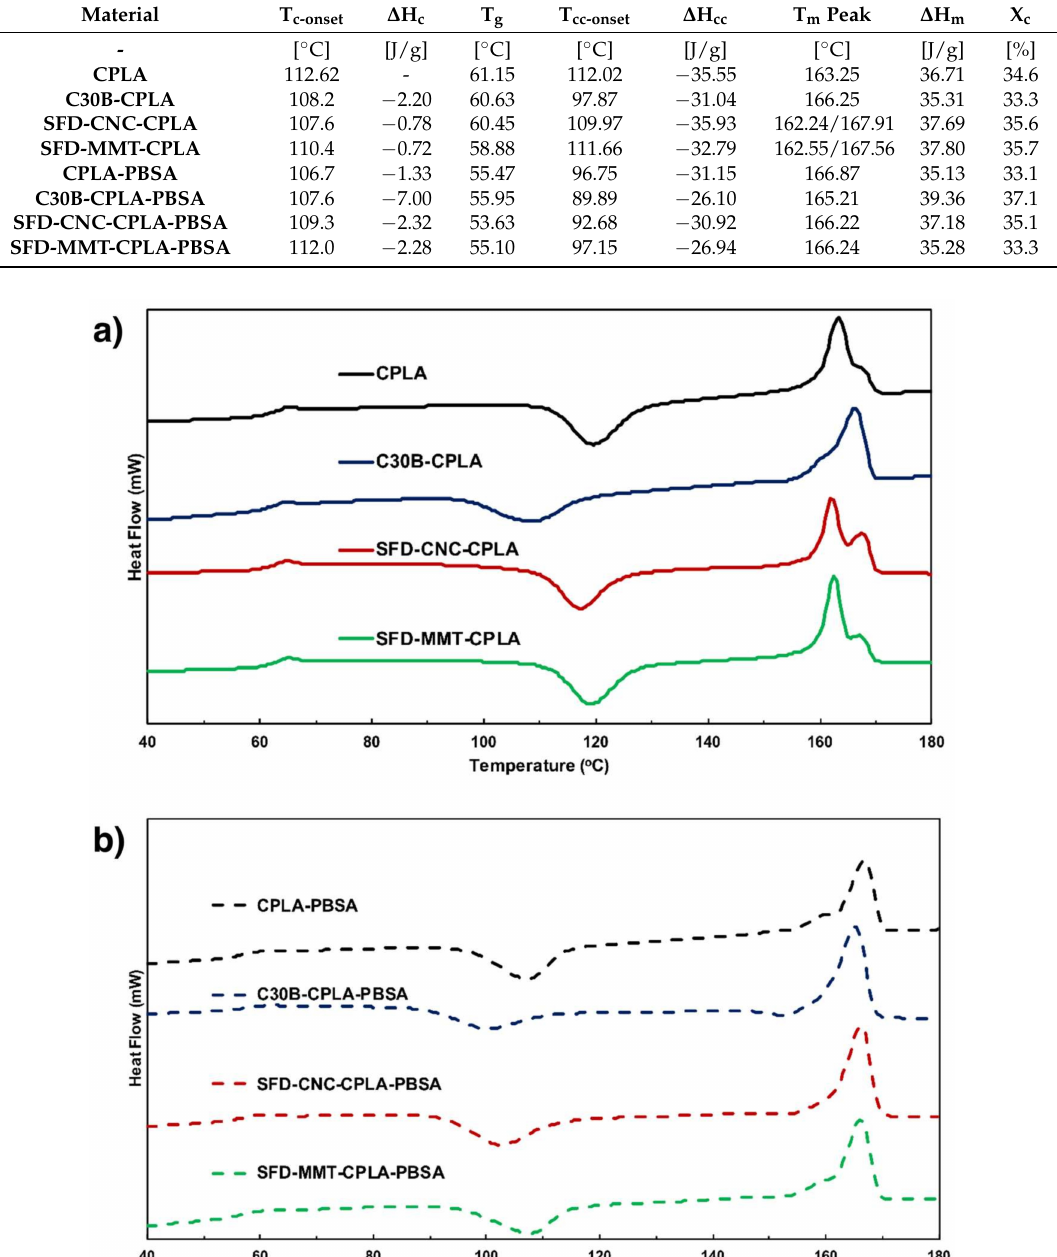
Table 3. DSC data for all PLA compositions.